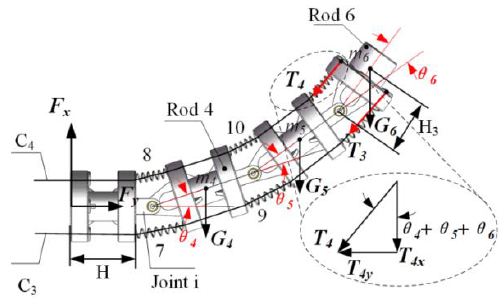
Figure 7. Static analysis of CDFM.